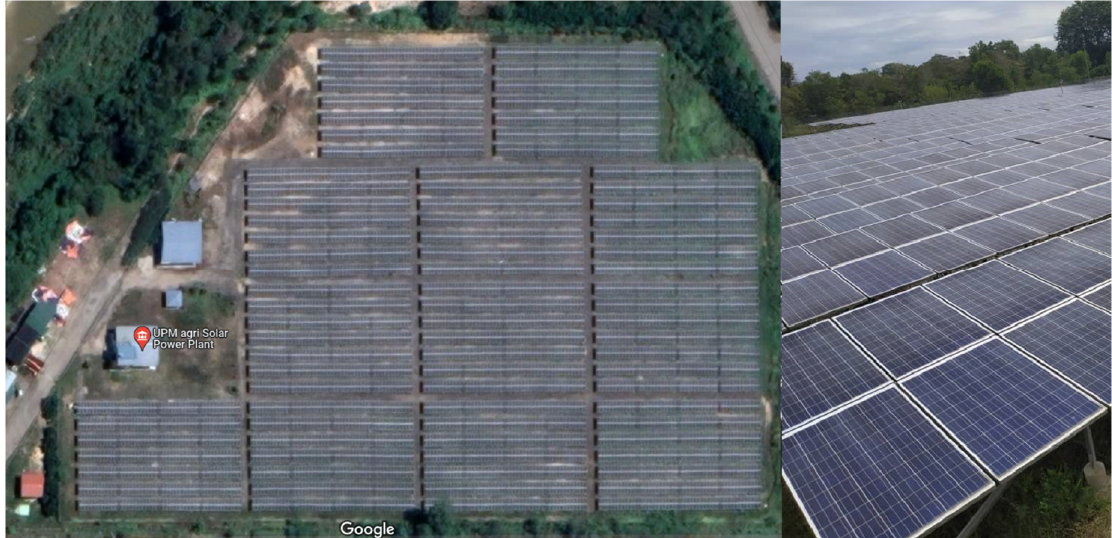
Figure 6. Snapshots of 2MWp Puchong solar farm in Selangor.